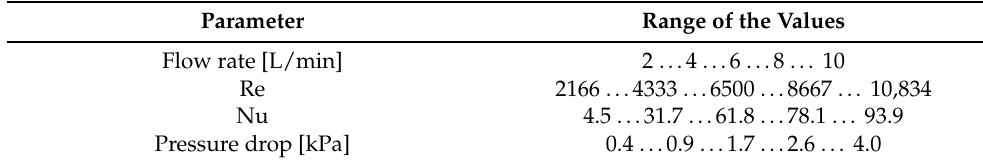
Table 1. Nusselt numbers and pressure drops in the